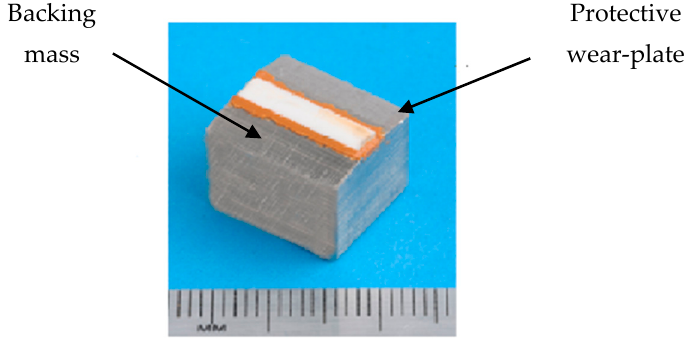
Figure 1. Current state-of-the art transducer typical of those found with wrapped around electrodes. Labels are inserted to indicate the two features visible externally, the backing mass and the protective wear-plate.